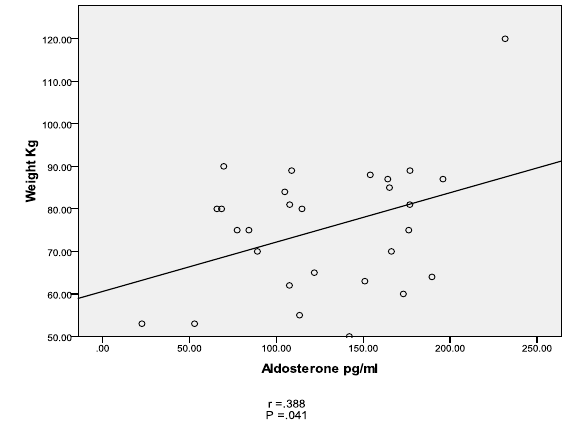
Figure (7) Significant correlation between weight and aldosterone in group B.